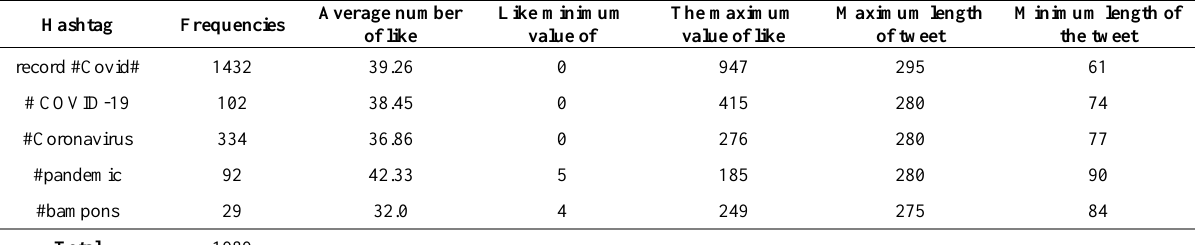
Table 3. Statistics related to each extracted hashtag